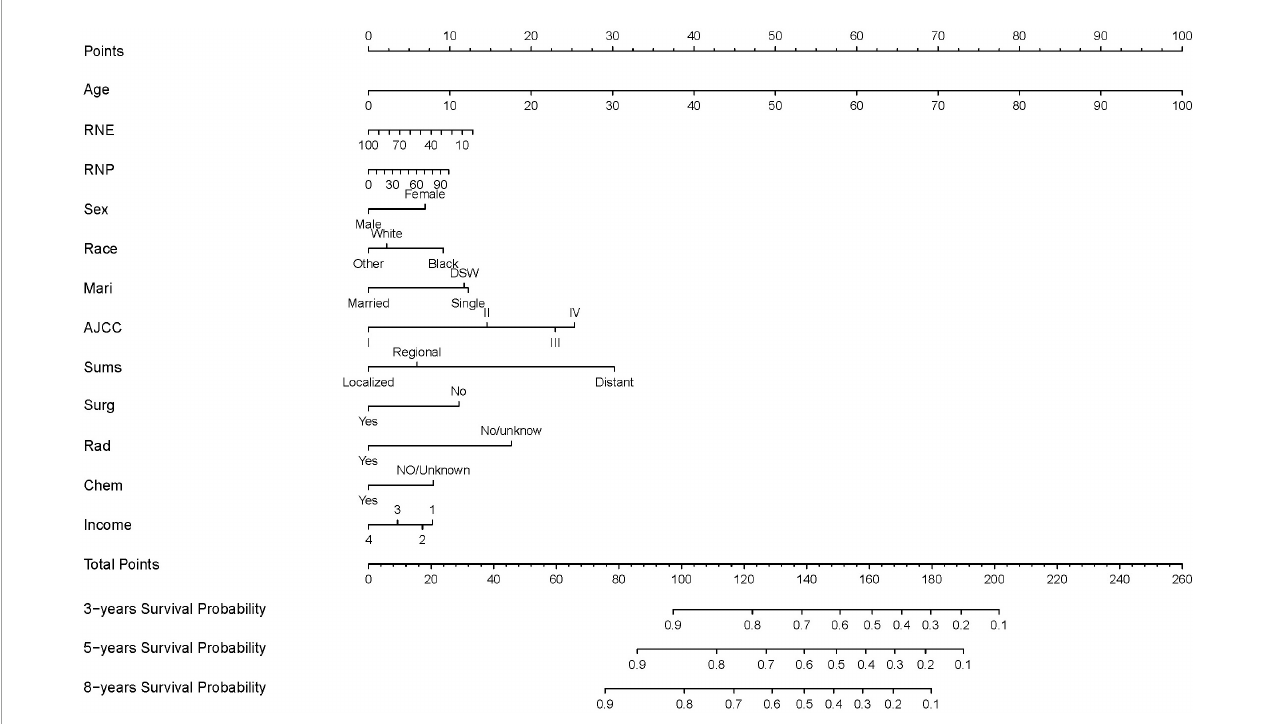
FIGURE2 Nomogram predicting 3-, 5-, and 8-years CSS probability. Mari, marital status; Sums, summary of stage; Surg, surgery status; Rad, radiotherapy status; Chem, chemotherapy status; DSW, divorced, spereated, or widowed; income 1: < $35,000, $35,000–$44,999; income 2, $45,000–$59,999; income